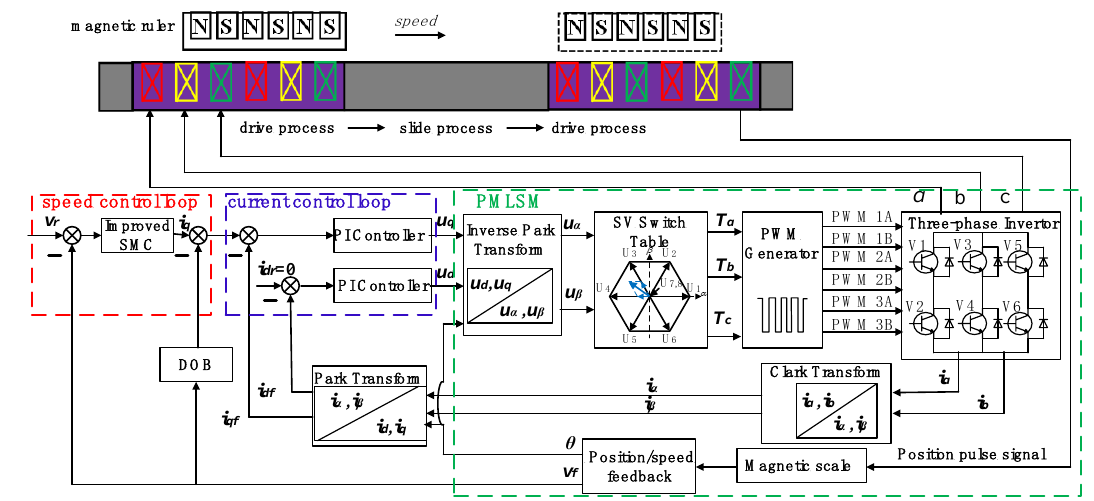
Figure 2. Control scheme of segmented PMLSM during the drive process.